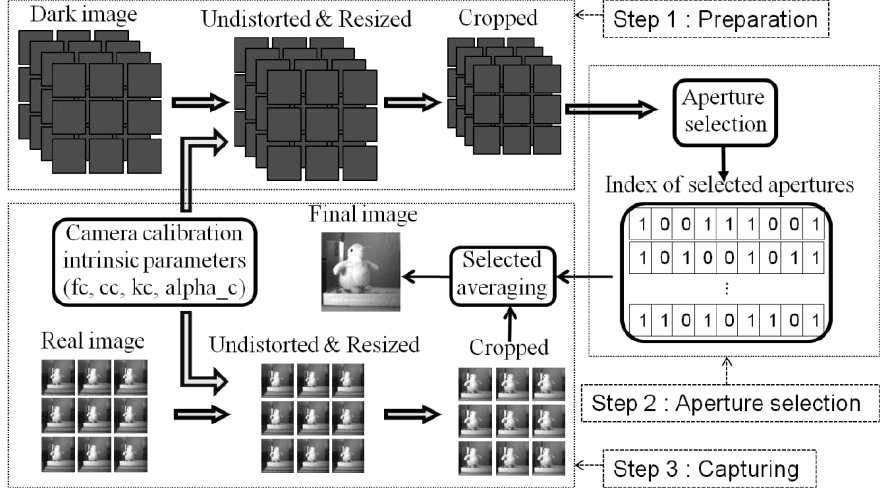
Figure 9. Flow chart of single image reproduction with selective averaging in multi-aperture